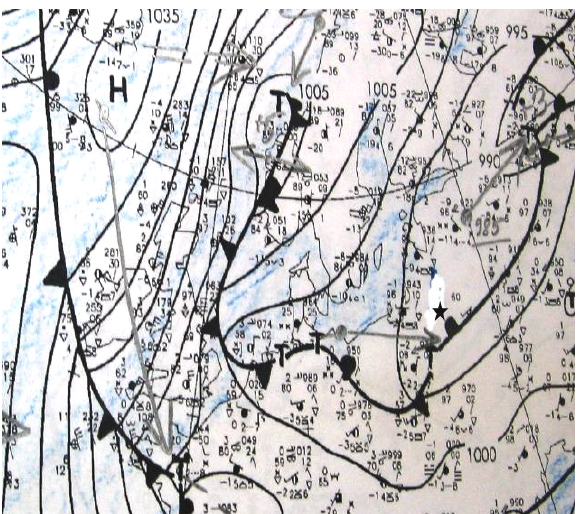
Fig. 16. 27 Jan. 2003 14 h. No HCRF decease. Fig. 18. 29 Jan. 2003 14 h. No HCRF decrease. Cyclone motion eastward Cyclone motion eastward